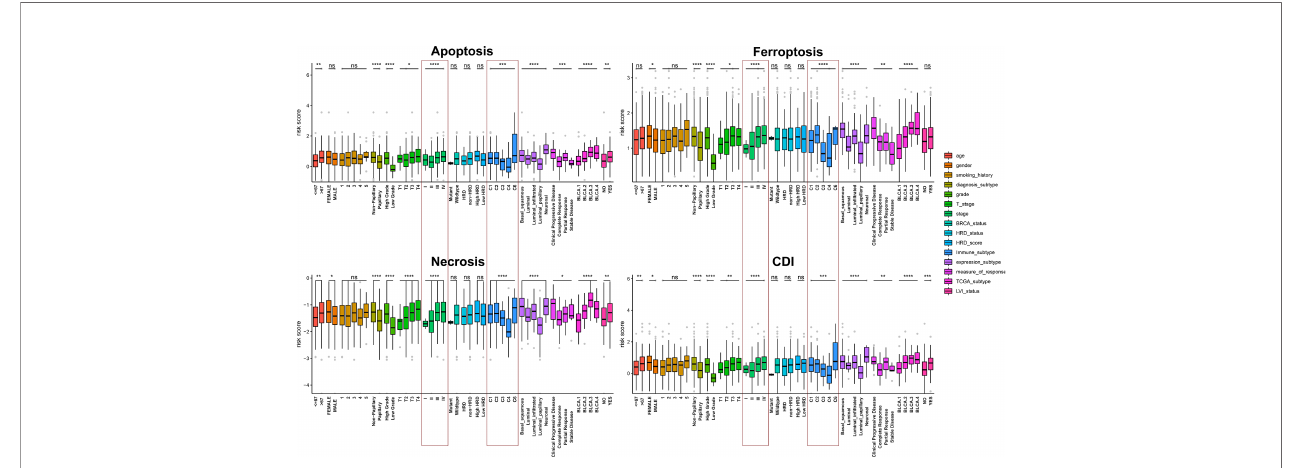
FIGURE 4 | Assessment of the relationship between clinicopathological characteristics and cell-death pathways. *, P < 0.05; **, P < 0.01; ***, P < 0.001; ****, P < 0.0001.